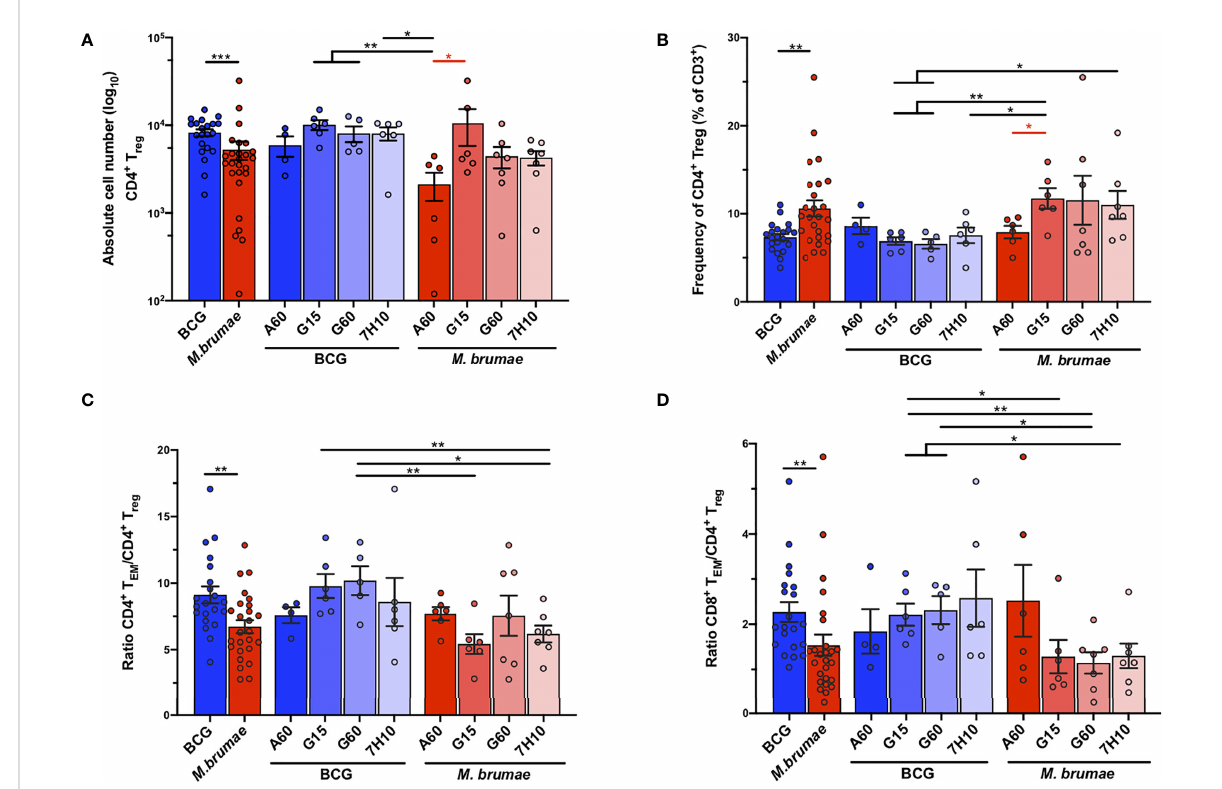
FIGURE 5 Changes in the in fi ltration of CD4 + T regs after BCG and M. brumae treatment. Absolute counts (A) and percentages (B) of in fi ltrating CD4 + T regs ( CD3 + CD4 + CD25 + CD127 - ). (C) ratio of CD4 + T (D) CD8 + T M. brumae -treated tumor- + T EM and EM to CD4 reg cells. Data are shown in BCG- and bearing mice pooled or divided by groups according to the medium used to growth mycobacteria. BCG (blue bars and dots). M. brumae (red bars and dots). CD4 + T EM : CD3 + CD4 + CD44 + CD62L - . CD8 + T EM : CD3 + CD8 + CD44 + CD62L - . Statistically signi fi cant differences between the different M. brumae mycobacteria are shown as red lines. Interstrain differences are shown in black.Data represent the mean (bars) and ± SEM (error bars). Each dot represent an individual mouse. Differences were tested using Mann-Whitney U nonparametric test. *p ≤ 0.05; **p ≤ 0.01; ***p ≤